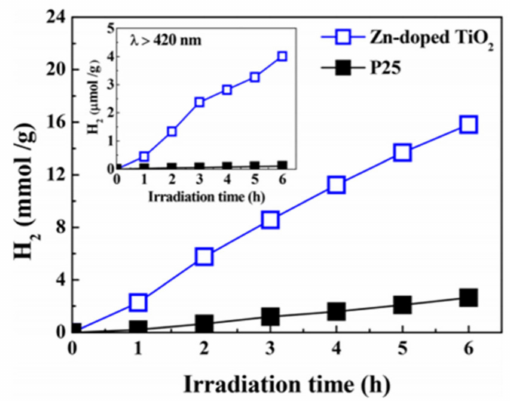
Figure 18. Hydrogen evolution from water splitting by Zn-doped TiO 2 nanotubes. The inset shows hydrogen evolution under visible light Reprinted with permission from ref. [185]. Copyright © 2021 American Chemical